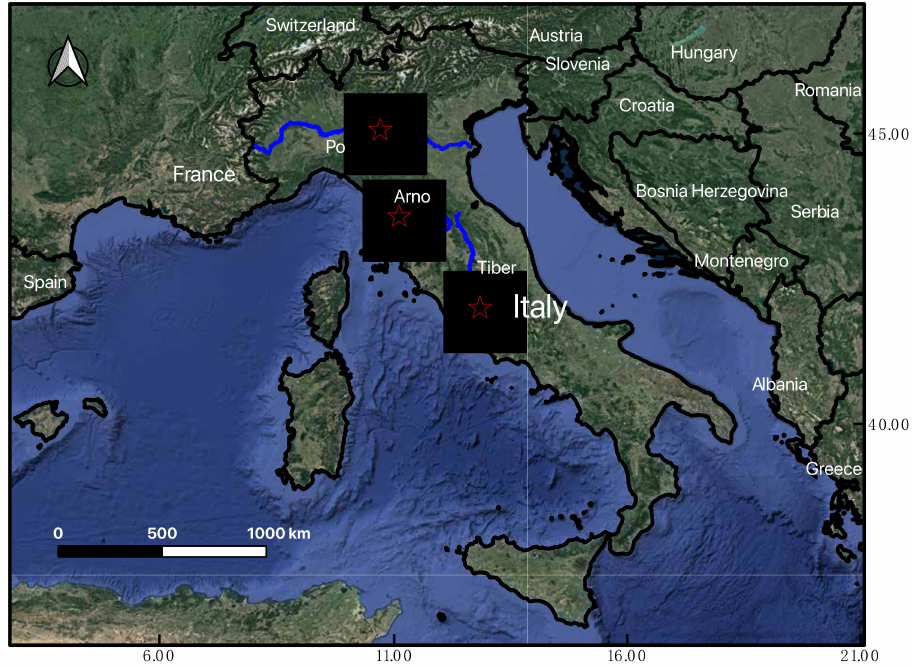
Figure 2. Satellite map of Italy, showing the main river systems (Po, Tiber and Arno) whose deltas have fed the highstand deposits of the Italian continental